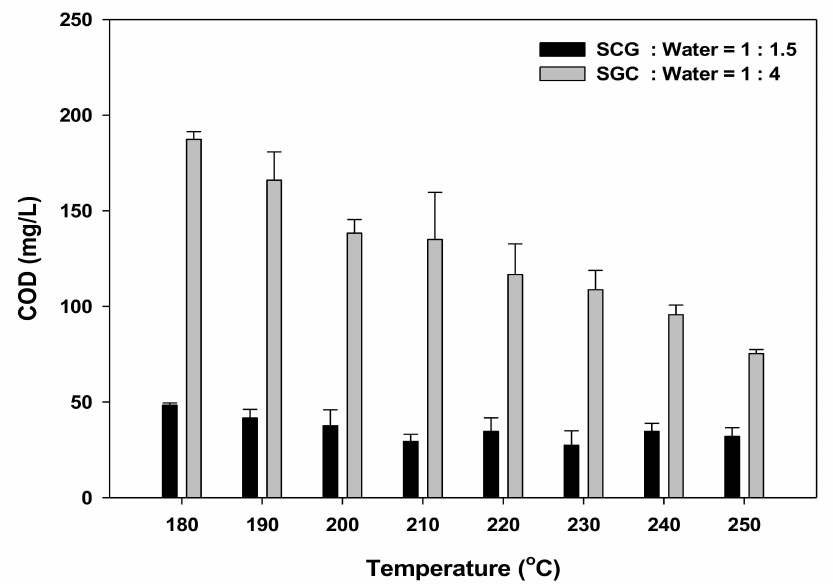
Figure 12. Chemical oxygen demand of SCGs produced with different reaction temperatures and water